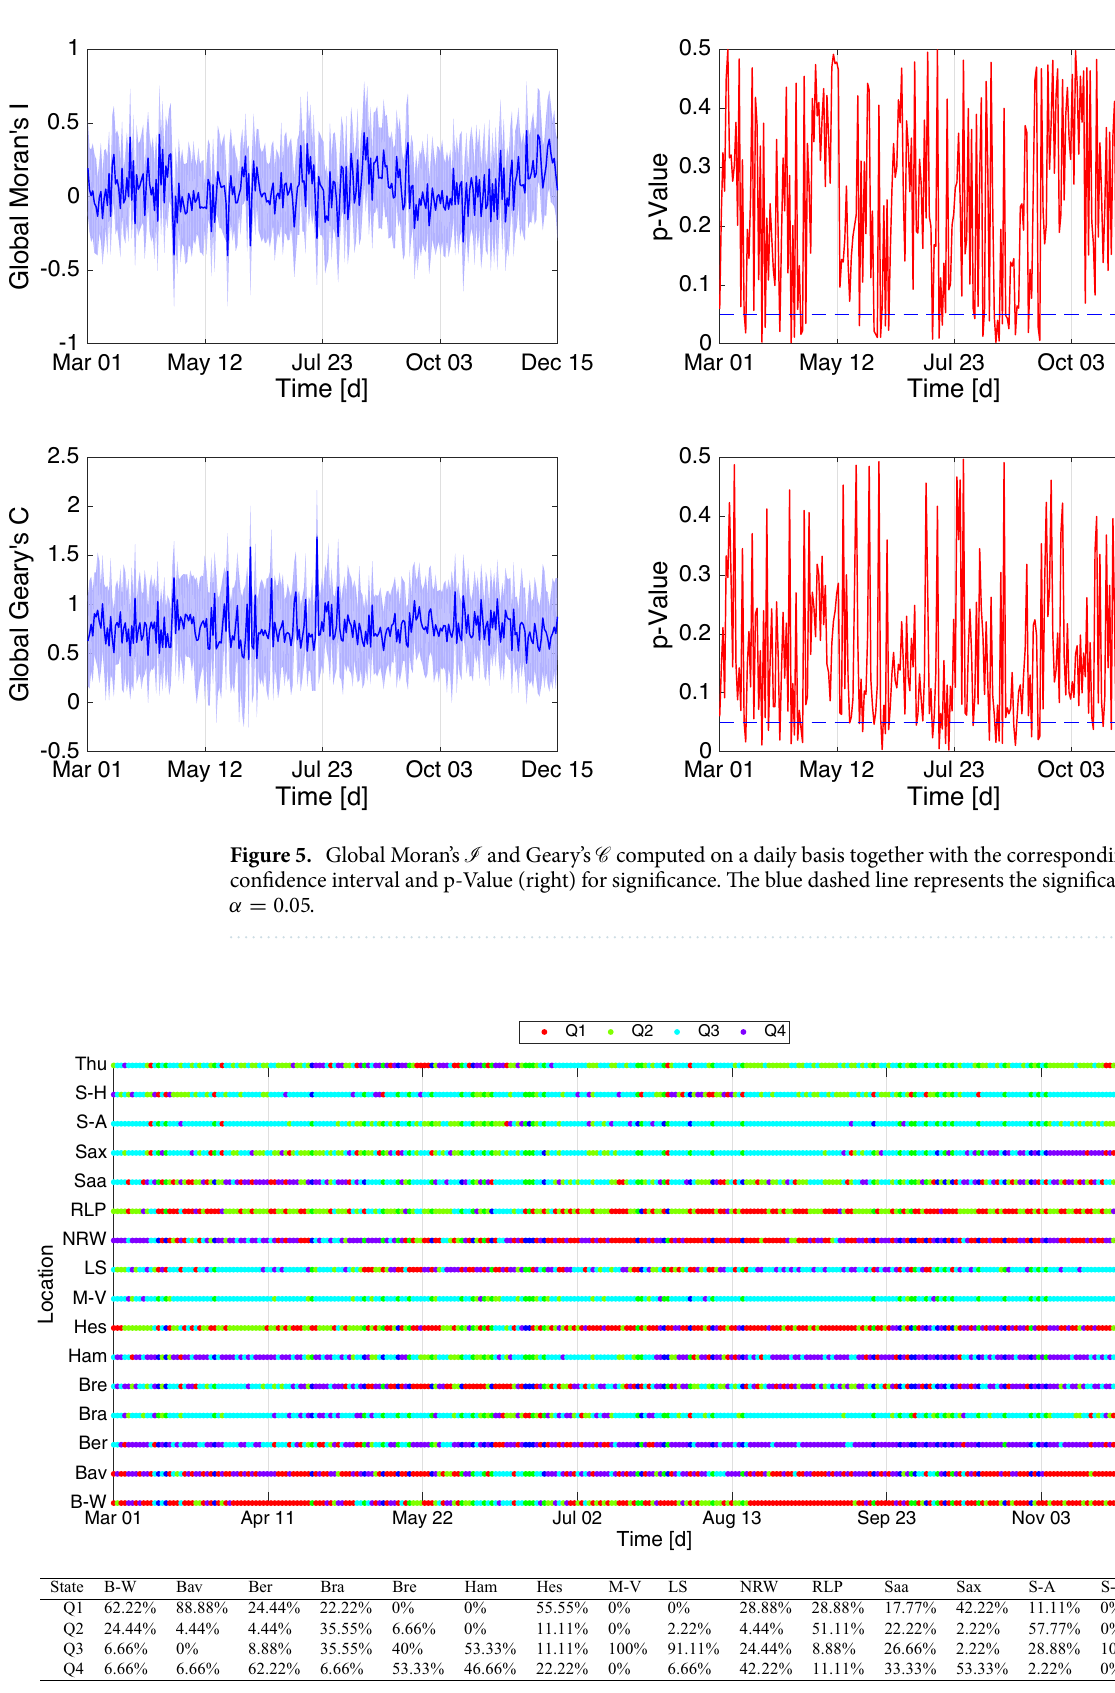
Figure 6. Classification into four quadrants ( Q1, Q2, Q3, Q4 ) equivalent to Moran’s scatter plot and the concurrence percentages from November 1 to December 15,